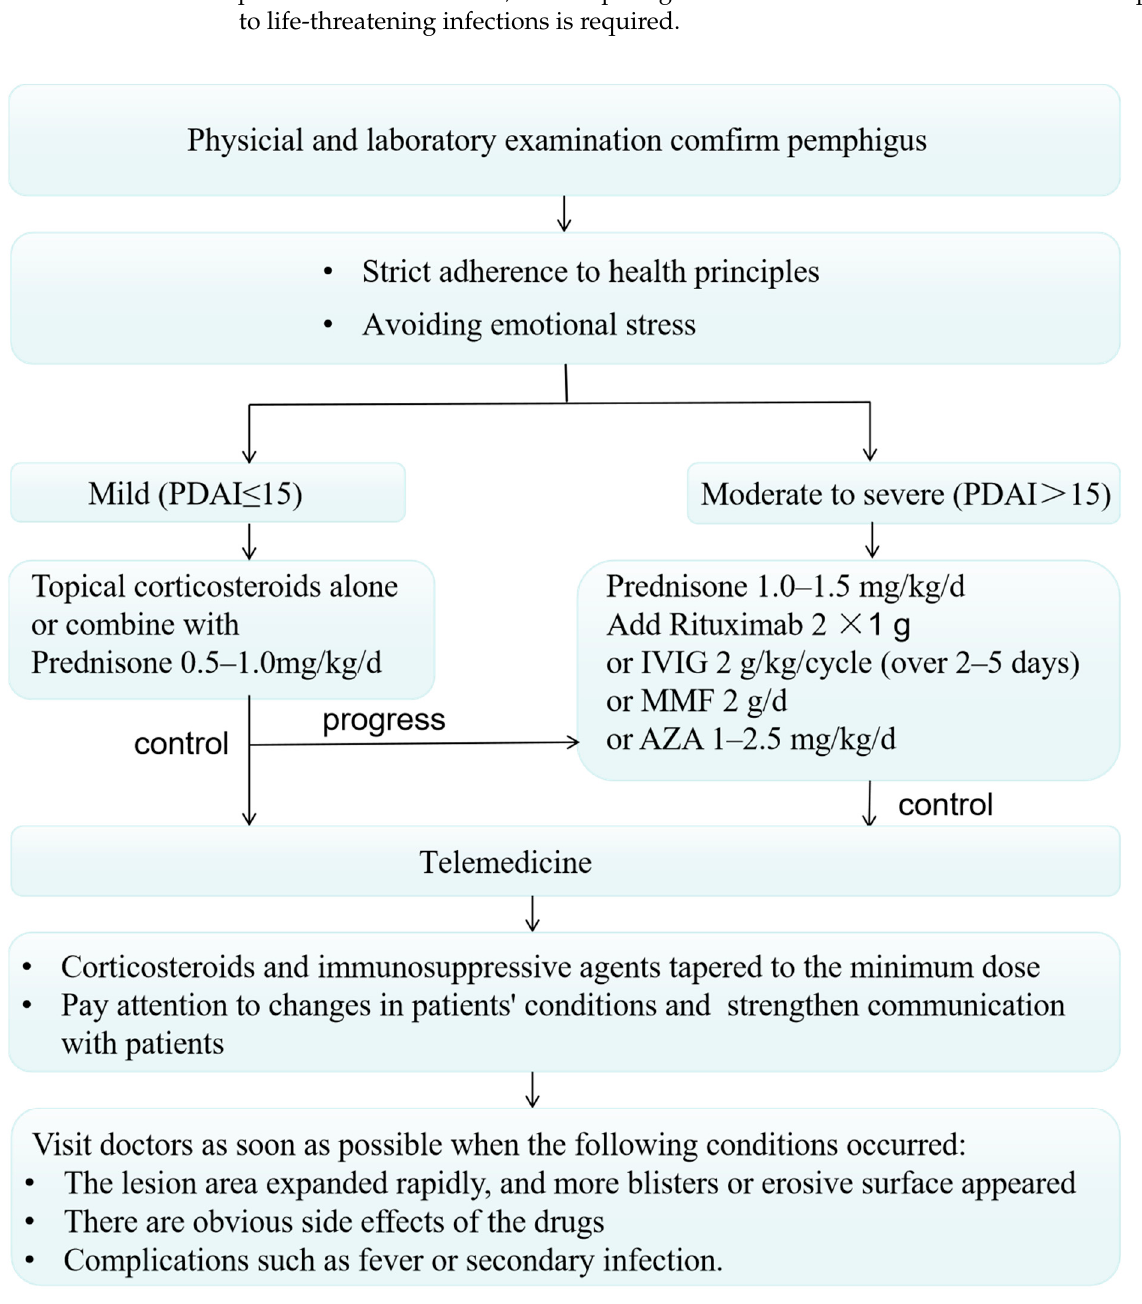
Figure 2. Flowchart of management strategies for pemphigus during the epidemic. PDAI, Pemphigus Disease Area Index; IVIG, intravenous immunoglobulin; MMF, mycophenolate mofetil; AZA, azathioprine.